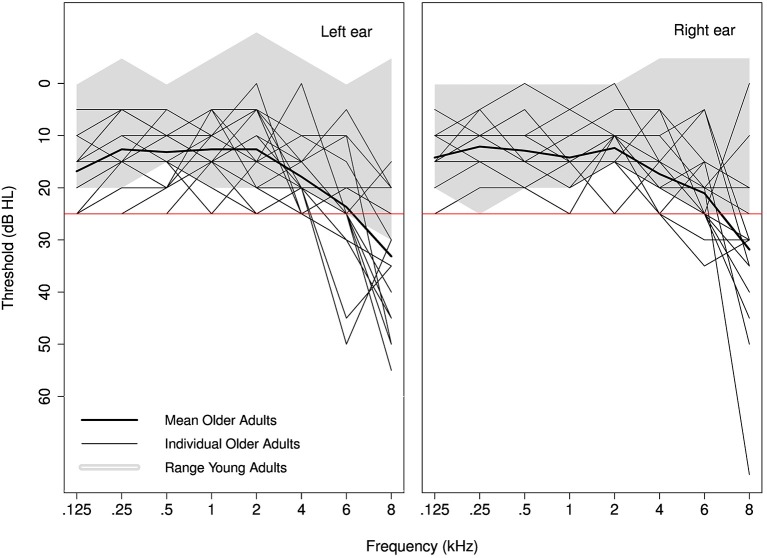
Individual audiograms for older adults are plotted for the left and right ear separately. The shaded area represents audiometric thresholds of the younger adults. The red line indicates the inclusion criterion of 25 dB HL.